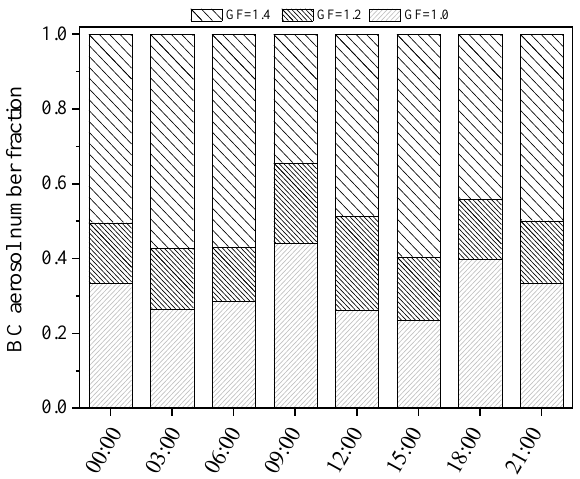
Figure 6. Diurnal variations in the GF distribution for BC parti- cles. The BC aerosol number fraction for each GF is defined as (BC aerosol number concentration for this GF) / (sum of BC aerosol number concentration for GF = 1.0, 1.2, and 1.4).